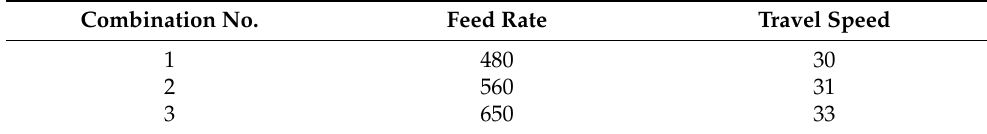
Table 2. WAAM dynamic process parameters.